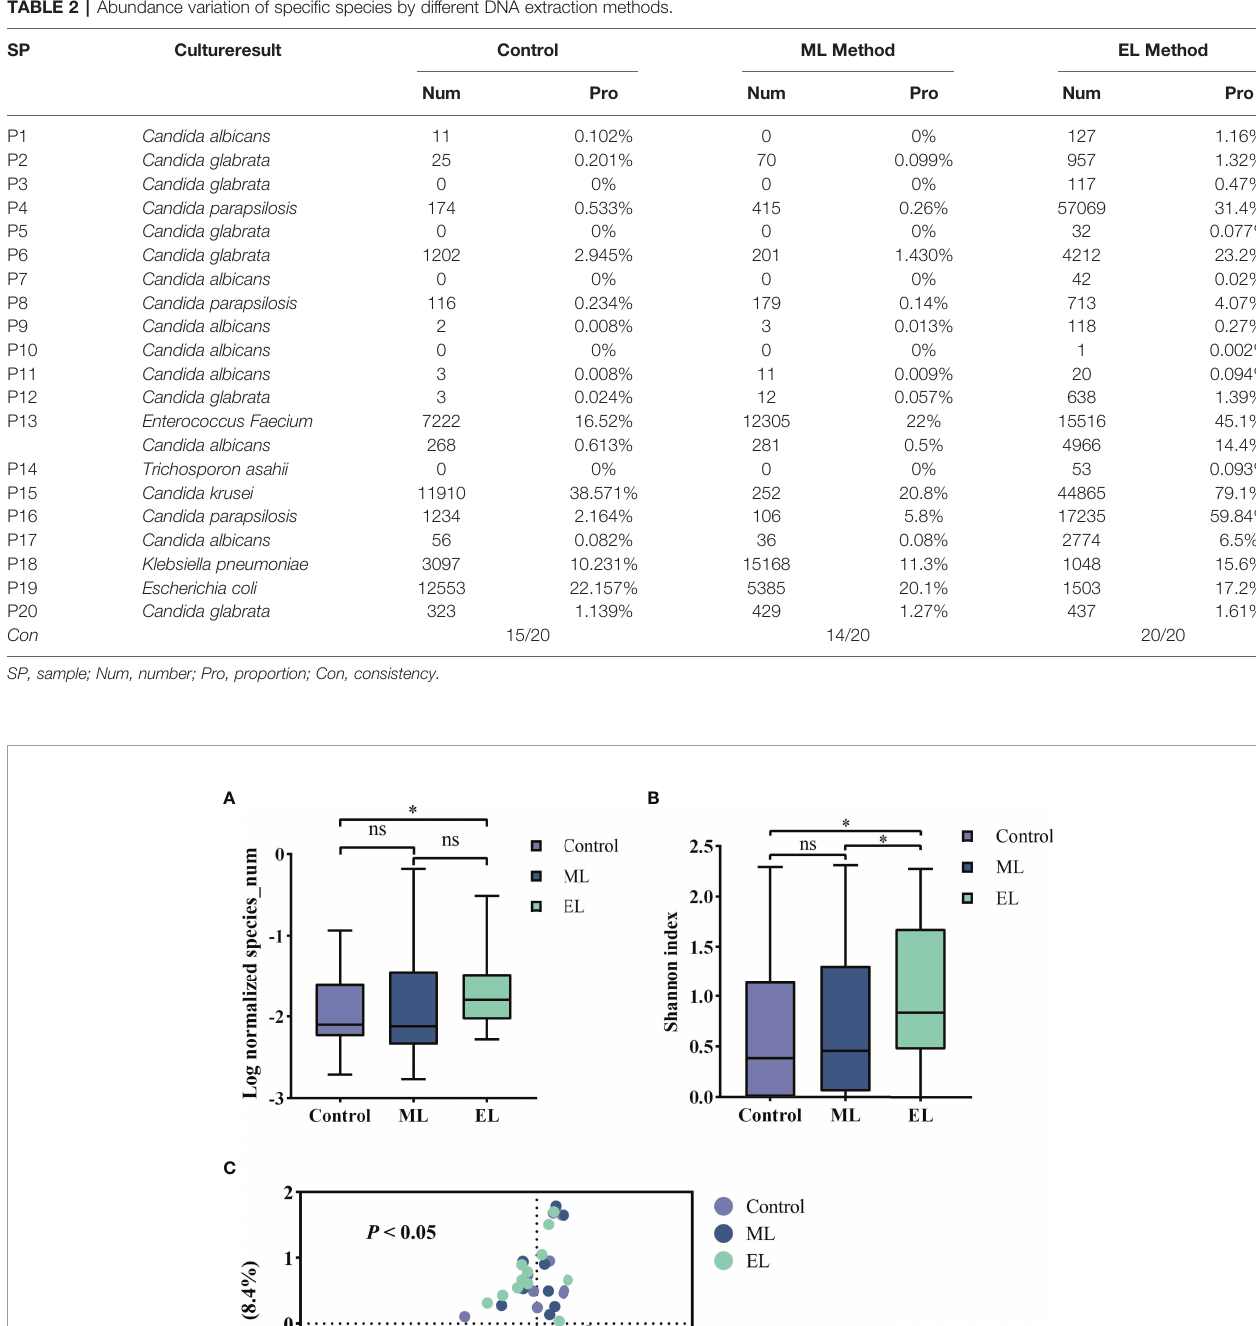
TABLE 2 | Abundance variation of speci fi c species by different DNA extraction